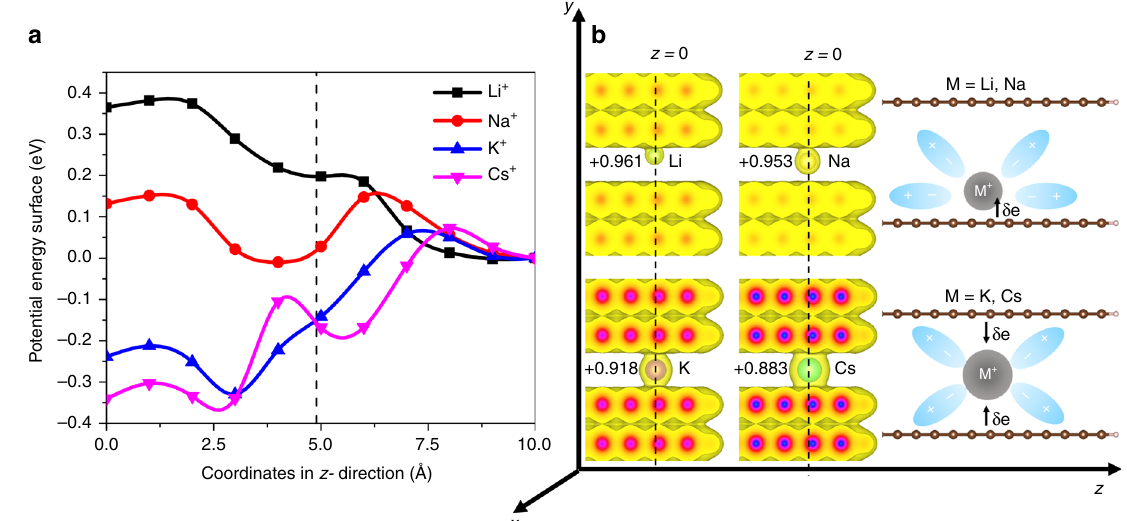
Fig. 2 Intercalation of alkali-metal cations into graphene slit pores. a Potential energy surface computed for the intercalation of the Li þ , Na þ , K þ , and Cs þ ¼ (cid:2) 1 e . The pore is at left, the bulk solution is at right, and the ions into a graphene slit pore with a pore diameter of d ¼ 6 Å and an excess charge of q grp dashed line indicates the location of edge hydrogen atoms at the pore opening. b Computed ionic charges and electronic density of the cation-intercalated graphene slit pores with the isosurface value set to 5 ´ 10 (cid:2) 3 a.u., and schematic description of con fi nement effects on the cation adsorption position and